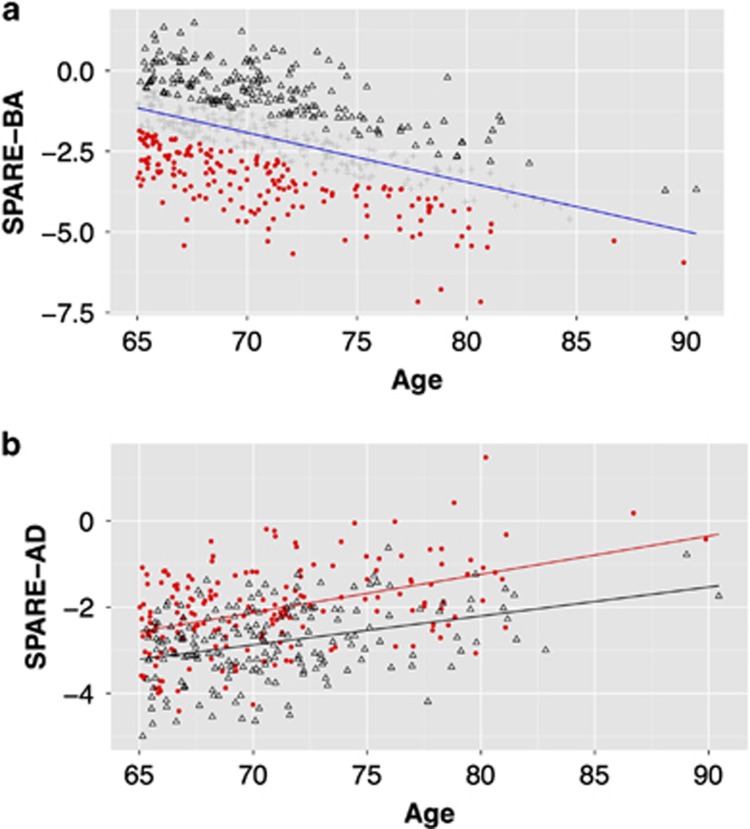
(a) SPARE-BA index for SHIP subjects ⩾65 years old. Values are reflecting relatively continuous progression of aging-related atrophy patterns with age. Based on SPARE-BA, we grouped these subjects into subjects with advanced brain aging (red dots; 0.5 s.d. below trend line) and resilient to brain aging (black triangles; 0.5 s.d. above trend line). (b) The relationship between age and SPARE-AD (reflecting clinical AD-like patterns of brain atrophy) in both groups. Advanced brain aging individuals have higher SPARE-AD values. SPARE-AD, Spatial Patterns of Abnormality for Recognition of Early Alzheimer's Disease; SPARE-BA, Spatial Pattern of Atrophy for Recognition of BA.